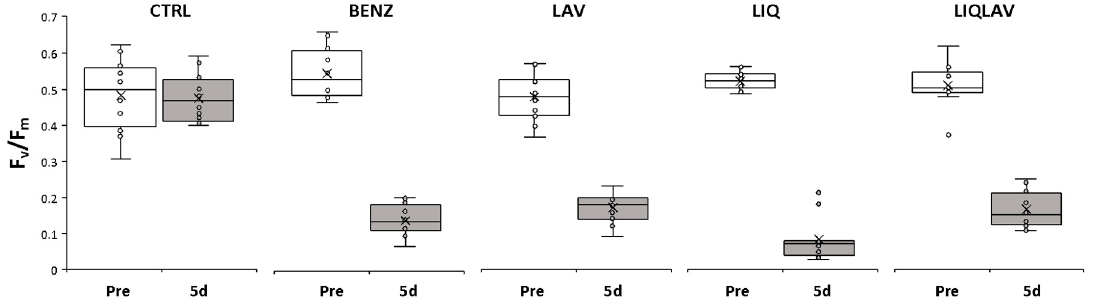
Figure 5. Changes in photosynthetic yield before each treatment (Pre) and after 5 days (5d) (n = 12). Control (CTRL), benzalkonium (BENZ, positive control), lavender at 5% (LAV), liquorice at 10% (LIQ) and a mixture of lavender 5% and liquorice 10% (LIQLAV).